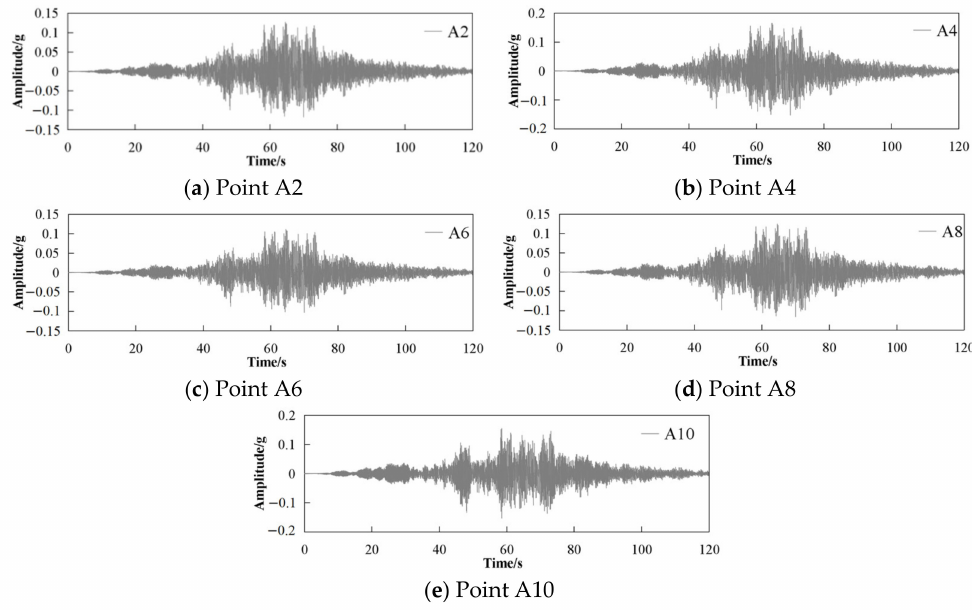
Figure 9. Acceleration time history of measuring points inside the slope: ( a ) A2, ( b ) A4, ( c ) A6, ( d ) A8, ( e ) A10.